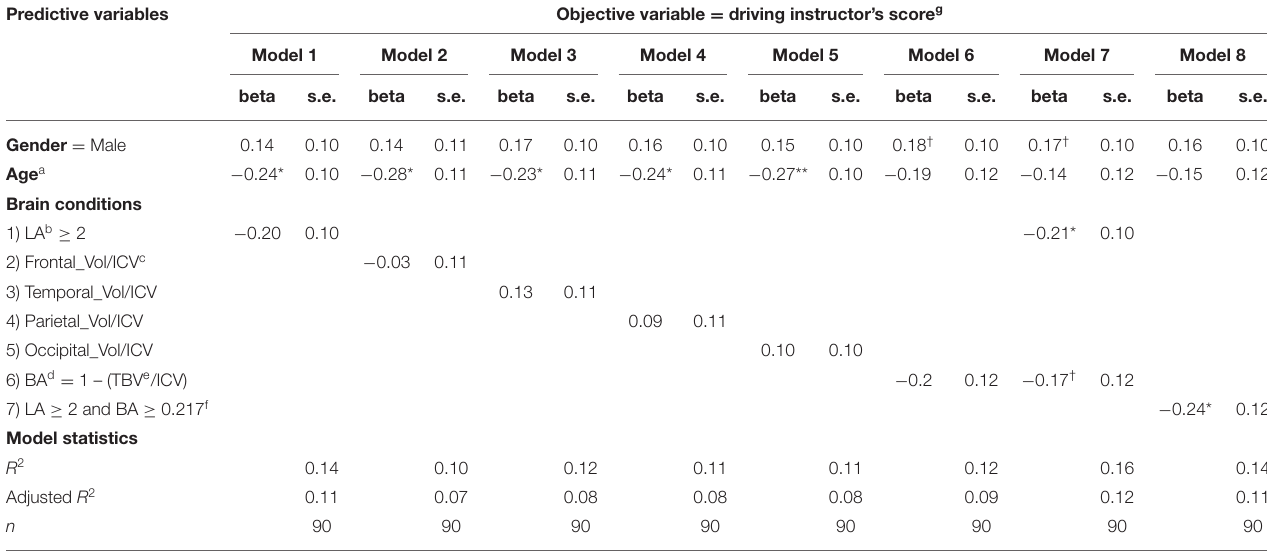
TABLE 2 | Regression analysis results with driving instructor’s scores (DIS). Predictive